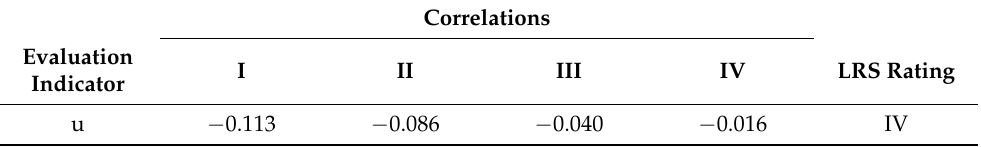
Table 17. Correlation matrix at the target